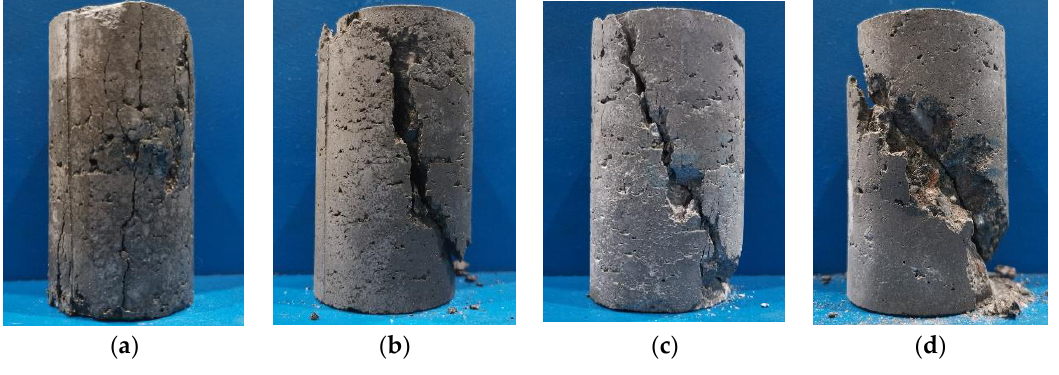
Figure 10. Failure mode of specimens under different confining pressures: ( a ) σ 2 = σ 3 = 0 MPa; ( b ) σ 2 = σ 3 = 5 MPa; ( c ) σ 2 = σ 3 = 10 MPa; ( d ) σ 2 = σ 3 = 15 MPa.